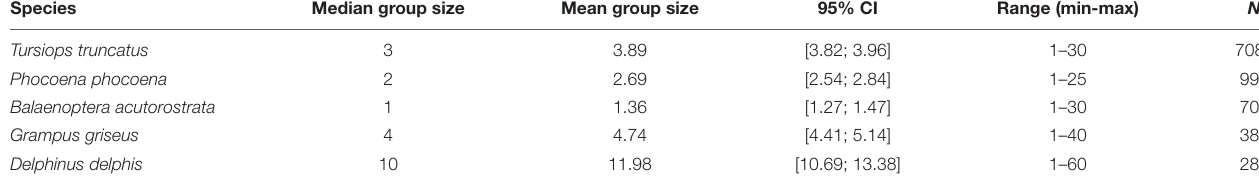
TABLE 5 | Mean group size and its 95% confidence intervals calculated via bootstrapping, minimum and maximum number of individuals in a group and sample size used for the five most sighted species. Species